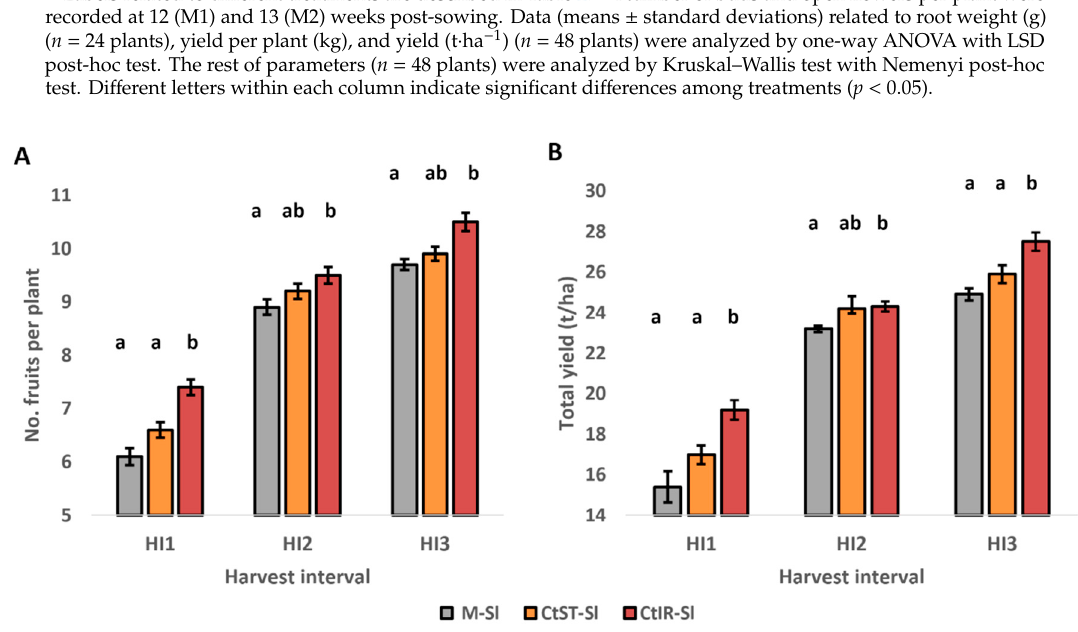
Figure 3. E ff ect of Ct0861 on number of fruits per plant ( A ) and total yield ( B ) split by harvest interval (HI) of tomato grown in a production greenhouse. Labels related to di ff erent treatments are described in Table 2. Data correspond to a harvest period of 53 days divided in three regular intervals of 17 days. Yields were summed within each harvest interval. The number of fruits per plant ( n = 48 plants) were analyzed by Kruskal–Wallis test with Nemenyi post-hoc test. Yield (t · ha − 1 ) ( n = 48 plants) was analyzed by one-way ANOVA with LSD post-hoc test. Di ff erent letters within each harvest interval indicate significant di ff erences among treatments ( p < 0.05). Error bars represent standard errors.